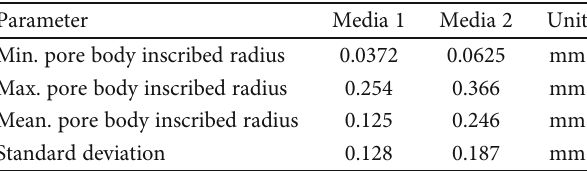
Figure 2: A porous media generated using pore network model with a designed structure. Table 1: Parameters for pore network